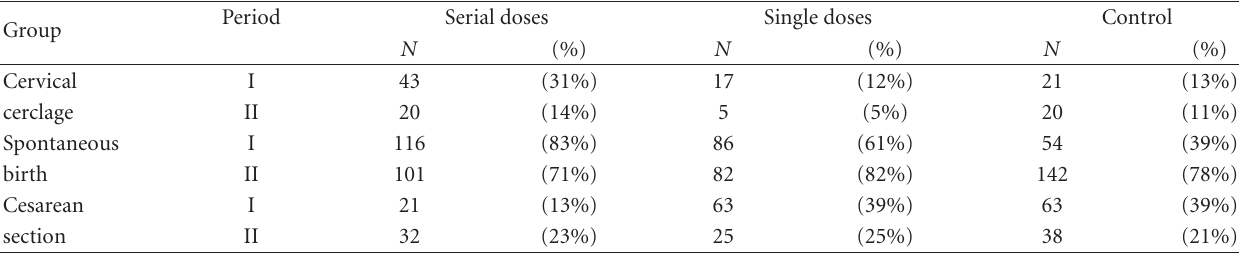
Table 3: Clinical characteristics of examined groups in the first (I) and second (II) periods.